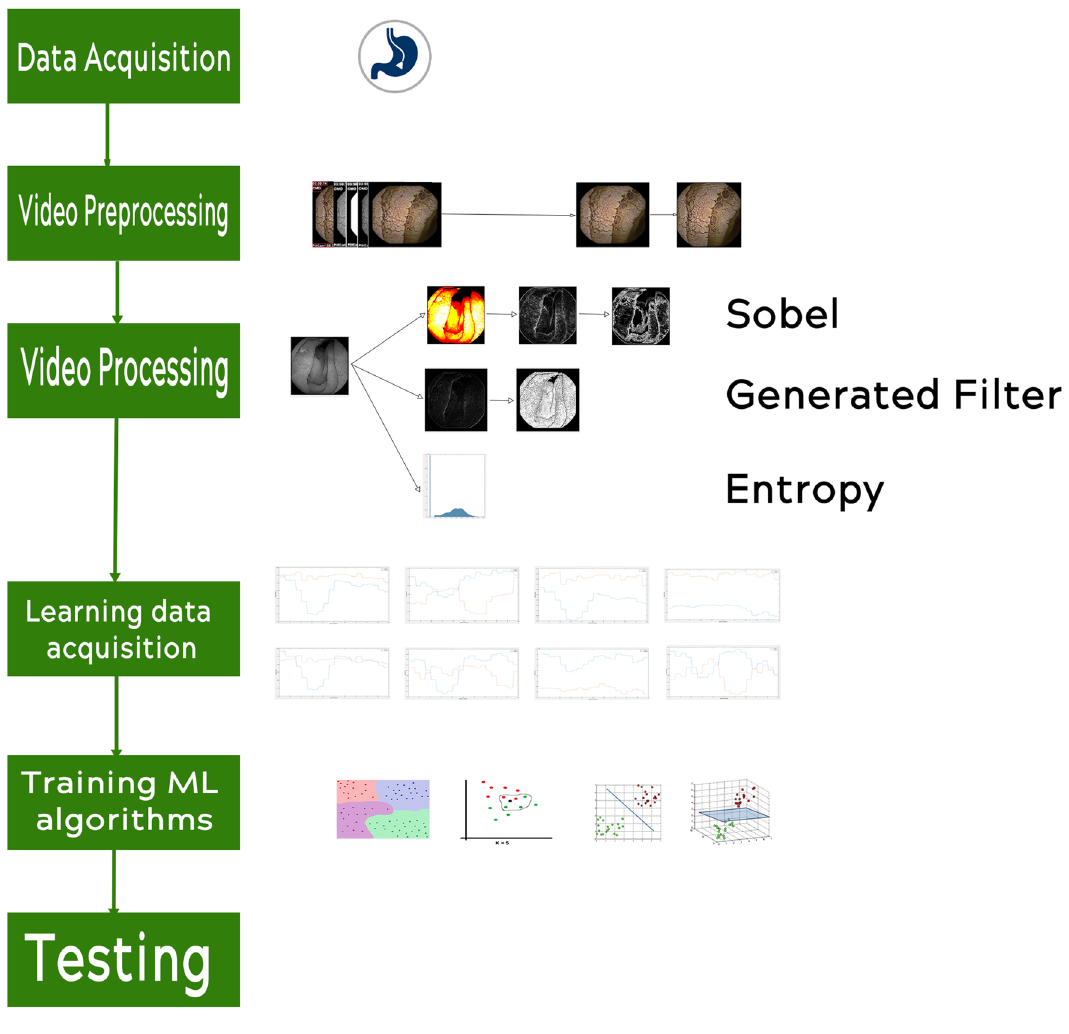
Figure 1. Experiment